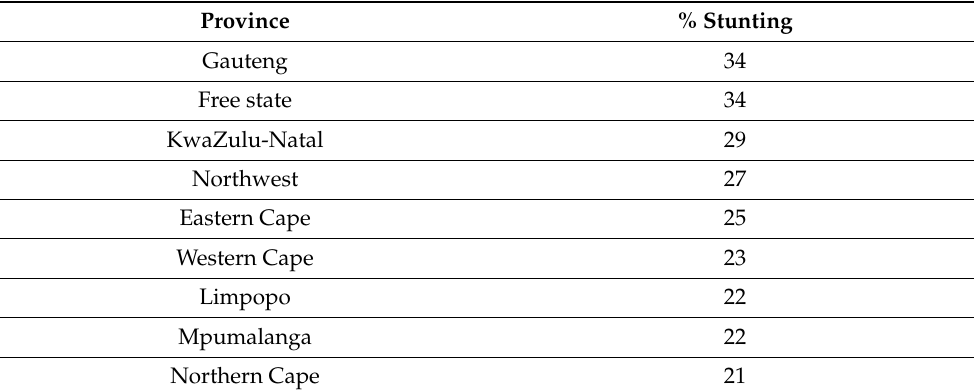
Table 1. Malnutrition in children 0–59 months in South Africa